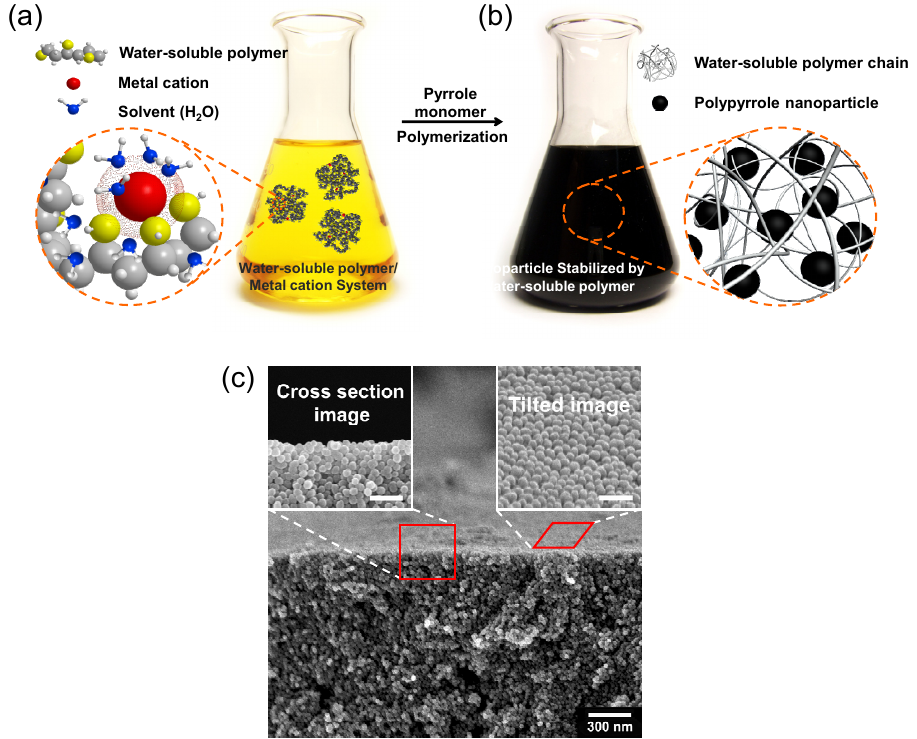
Figure 3. Schematic illustration of the formation of PPy nanoparticles in an aqueous dispersion of water-soluble polymer (PVA)/metal cation (ferric ion) complexes, and SEM images of the resulting nanoparticles. ( a ) Hydroxyl groups of PVA chains coordinate with ferric ions by an ion-dipole interaction in an aqueous medium; ( b ) The ferric ions act as the oxidizing agent for chemical oxidation of pyrrole monomers. After polymerization, the resulting PPy nanoparticles are stabilized by PVA chains; ( c ) Tilted and cross-section SEM images of the PPy nanoparticles stacked on a substrate (scale bar: 100 nm). With permission from [34]; Copyright 2010, Wiley-VCH Verlag GmbH & Co.